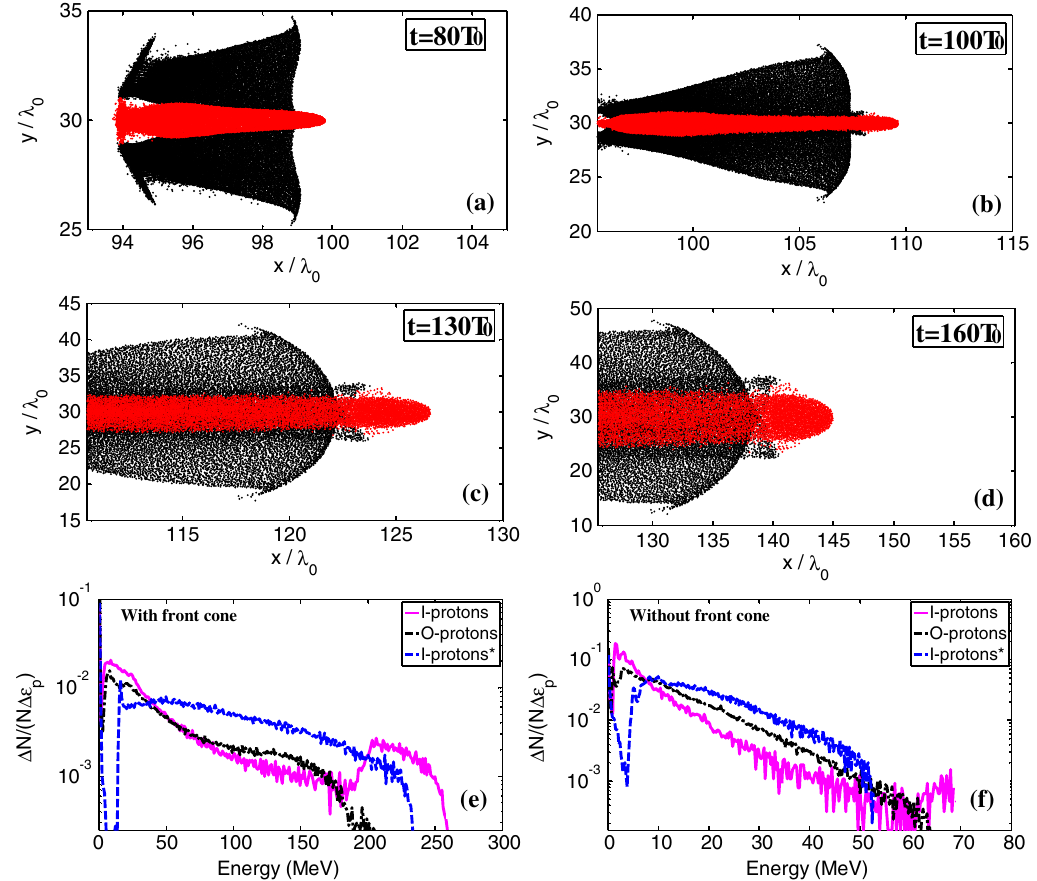
FIG. 2. 2D PIC simulation results of the spatial distribution of the I-protons (red dots) and O-protons (black dots) in the x - y plane at (a) t ¼ 80 T 0 , (b) t ¼ 100 T 0 , (c) t ¼ 130 T 0 , and (d) t ¼ 160 T 0 . The energy spectra for the I- and O-protons at t ¼ 160 T 0 are plotted in (e), where a spectrum marked as ‘‘I-protons*’’ is also plotted for the I-protons using the target without the O-proton layer initially for comparison and N is the total number of I- or O-protons. The laser parameters are a ¼ 12 , (cid:4) ¼ 30 T 0 , and w 0 ¼ 8 (cid:2) 0 . Plot (f) is obtained without the front